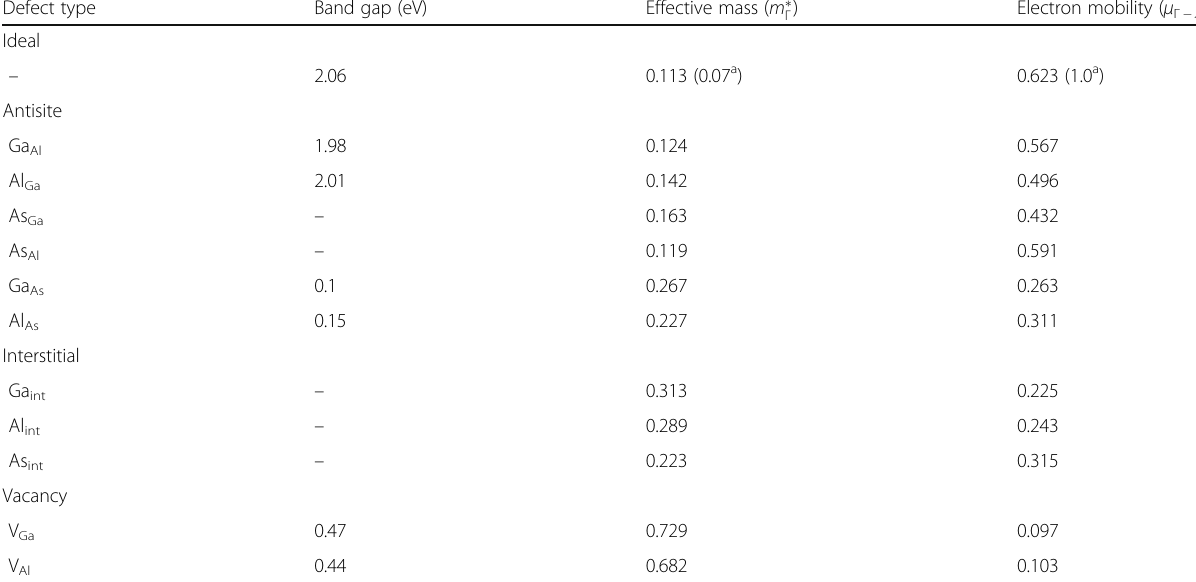
Table 5 The band gap, electron effective mass at the Γ point ( m (cid:3) Γ ), and electron mobility along the z direction, i.e., Γ -X direction in the Brillouin zone ( μ Γ − X ) for defective GaAs/AlAs